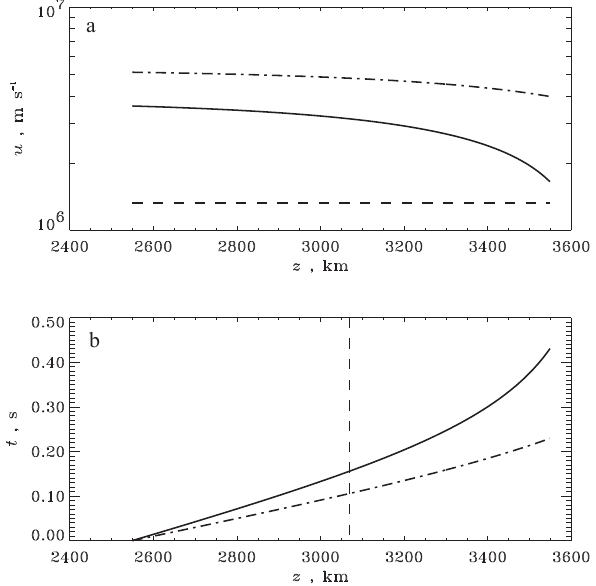
Fig. 9. Variation of (a) electron speed and (b) flight time with altitudes for two values of the electron velocity at the altitude z 1 = 2550km, 3 . 6 · 10 6 m s − 1 (solid line) and 5 . 1 · 10 6 m s − 1 (dashed-dotted line). The profile of the potential is taken in the form (49) with ϕ(z 1 ) = 5 V and h = 260km. A horizontal dashed line in the plot (a) presents the value of ( 2 e/m e )ϕ(z 1 ) and a verti- cal dashed line in the plot (b) shows the estimated upper boundary of the acceleration region.